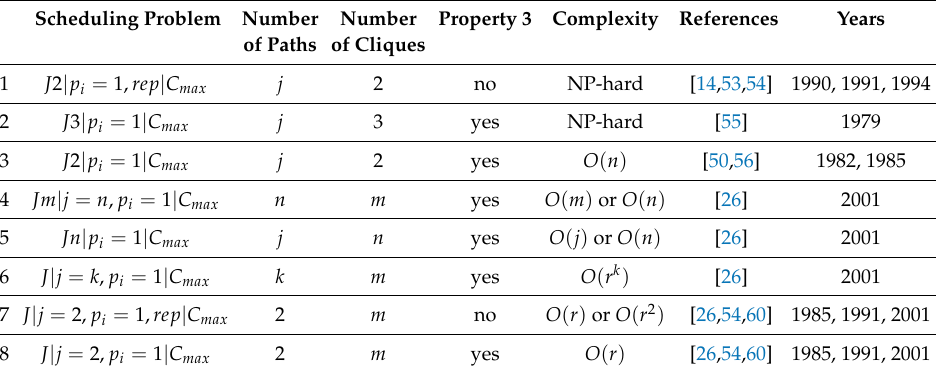
Table 5. The complexity of a mixed graph coloring with long paths or large